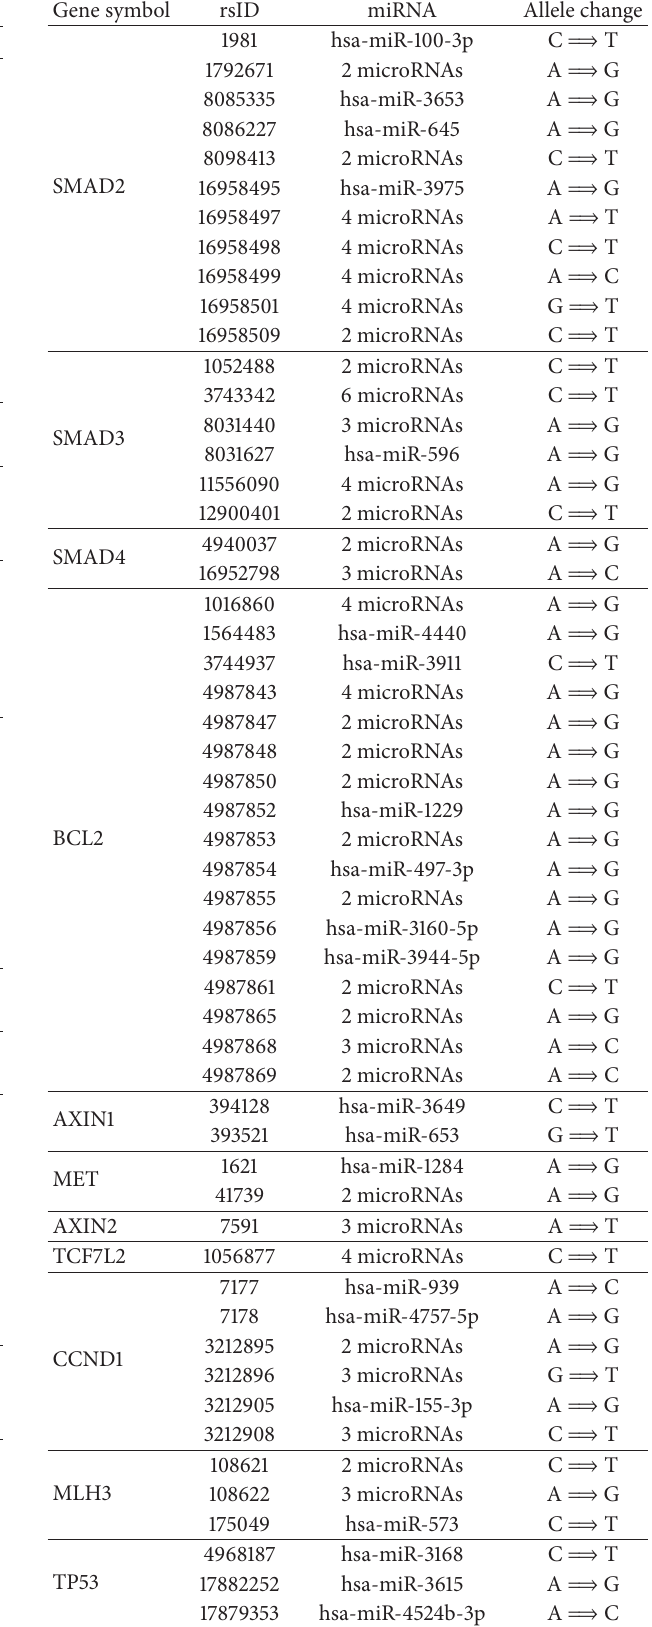
Table 1: Genes with disrupted or reduced efficiency binding sites, suggesting